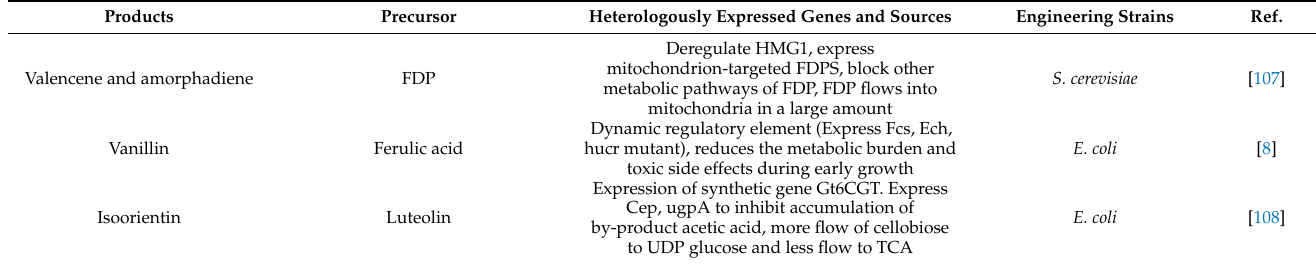
Table 3. Examples of optimization and control strategies through metabolic